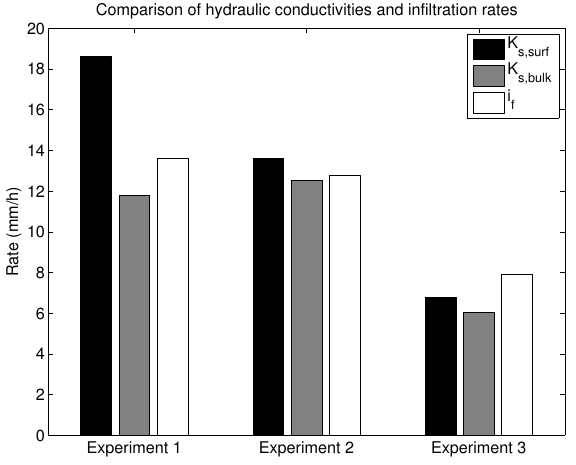
Figure 14. Rates for the optimization using ˆ b and ˆ ψ ae Comparison of infiltration and conductivity rates for the three experiments. Figure 12.